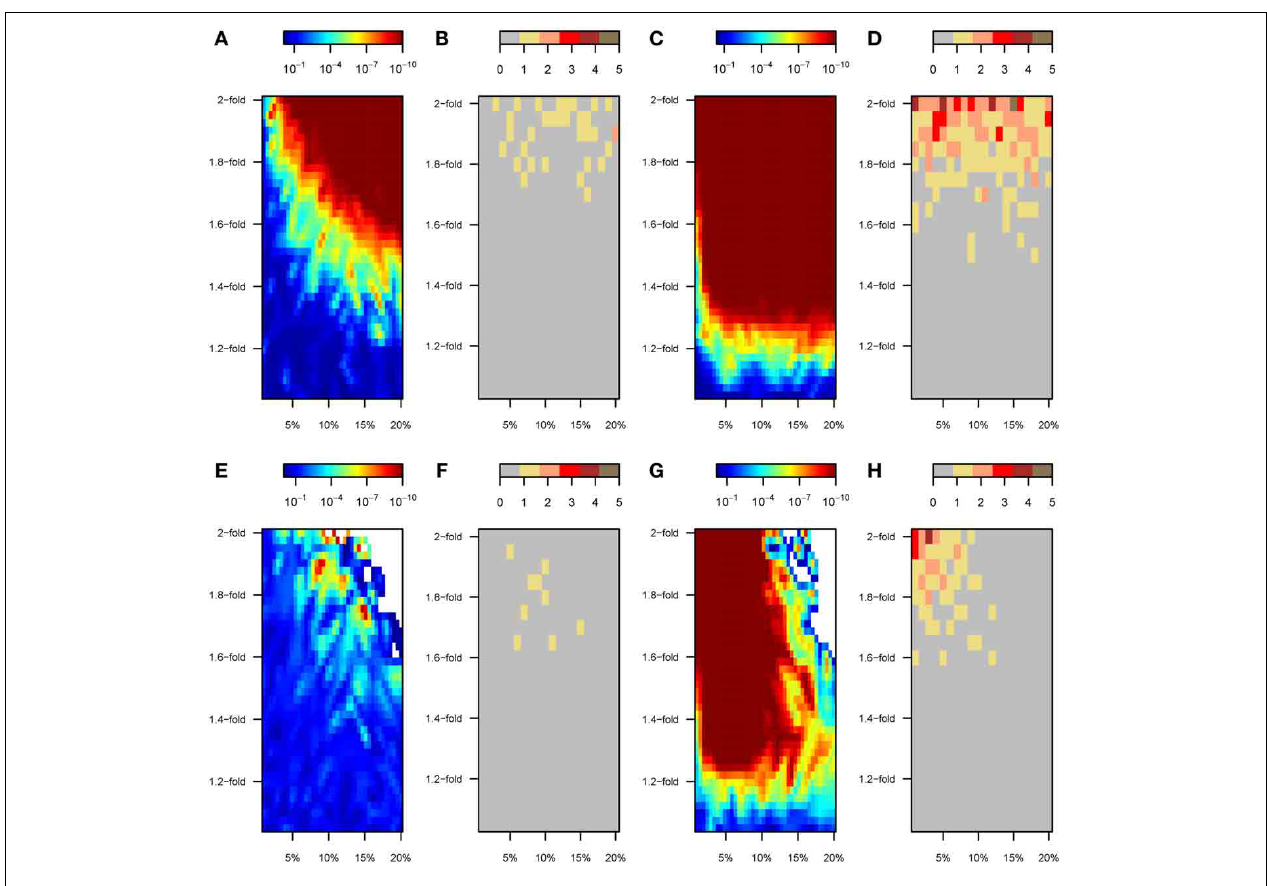
(C) P -value of the GRSxE interaction under model 2. (D) Number of SNPs at genome-wide significance levels ( P < 5 × 10 − 8 ) for GxE under model 2. The corresponding results for scenario C are shown in bottom panels (E–H) . Panels (B,D,F,H) record the largest number observed out of five permutations. White areas in top right corners in panels (E,G) correspond to parameter space with no SNPs detected by GWAS and thus missing GRSxE